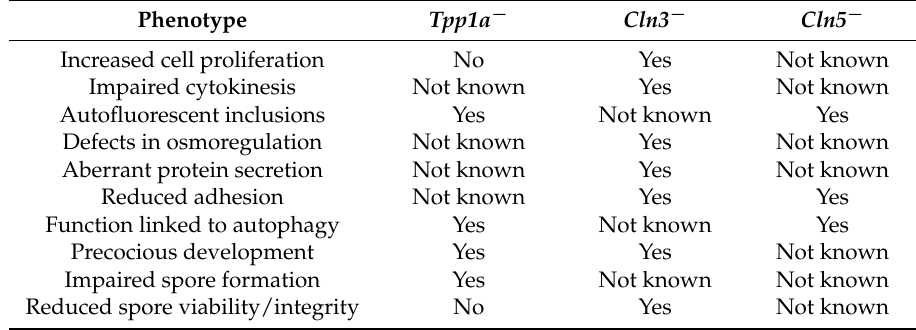
Table 2. Comparison of the phenotypes observed in Dictyostelium models of TPP1/CLN2, CLN3, and CLN5